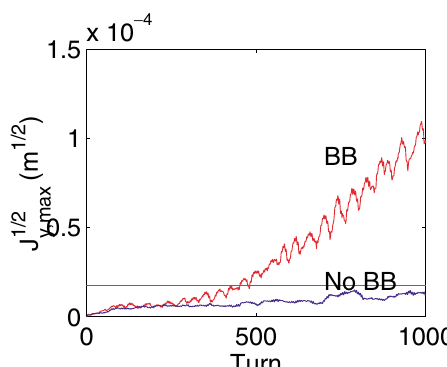
FIG. 6. (Color) y - z distribution of the positron bunch after 400 turns (a) and 800 turns (b). Different colors of the date points correspond to the bunch shapes with (red) and without (green) beam-beam